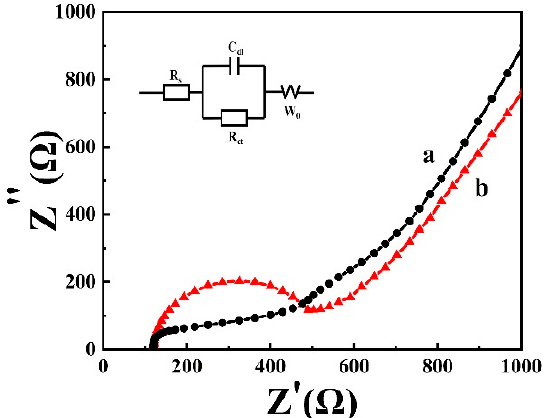
Figure 4. Electrochemical impedance spectra plots of CLR-PC/GCE (a)and GCE (b). Electrodes were in 1 mmol·L − 1 [Fe(CN) 6 ] 3-/4- containing 0.1 mol·L − 1 KCl.